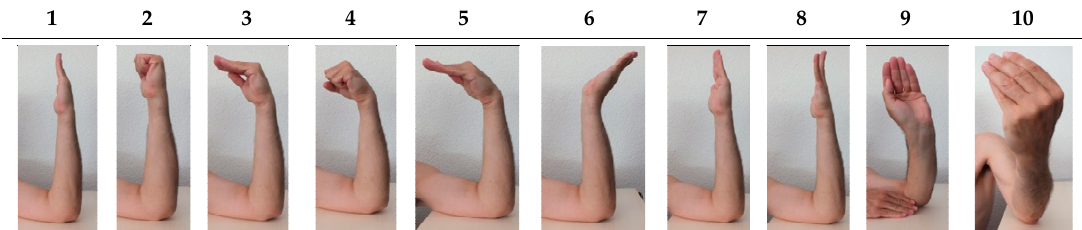
Table 2. Images of hand positions defined for the motion detection evaluation.